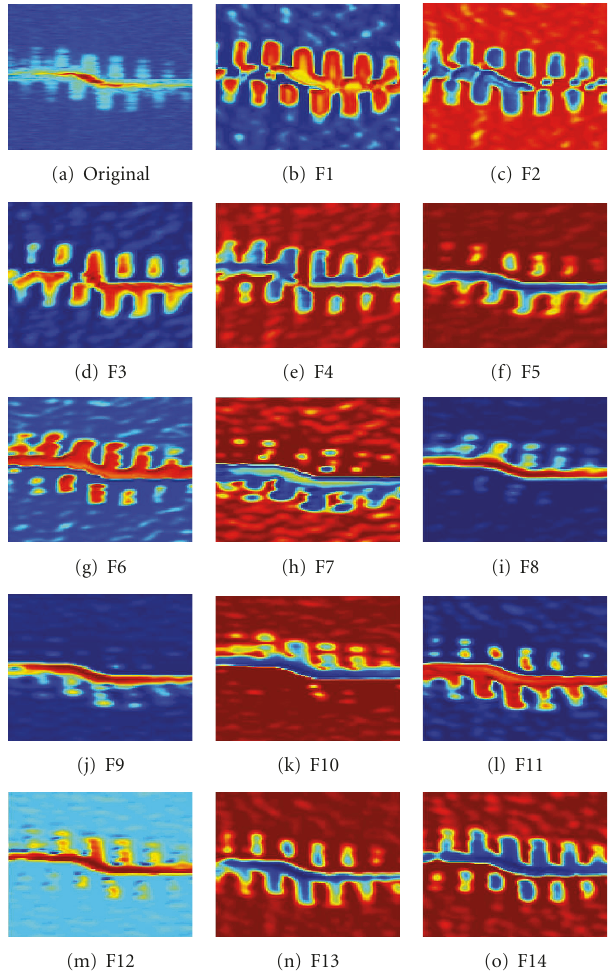
Figure 11: Outputs of Stage 2 filters for one-arm spectrogram input.